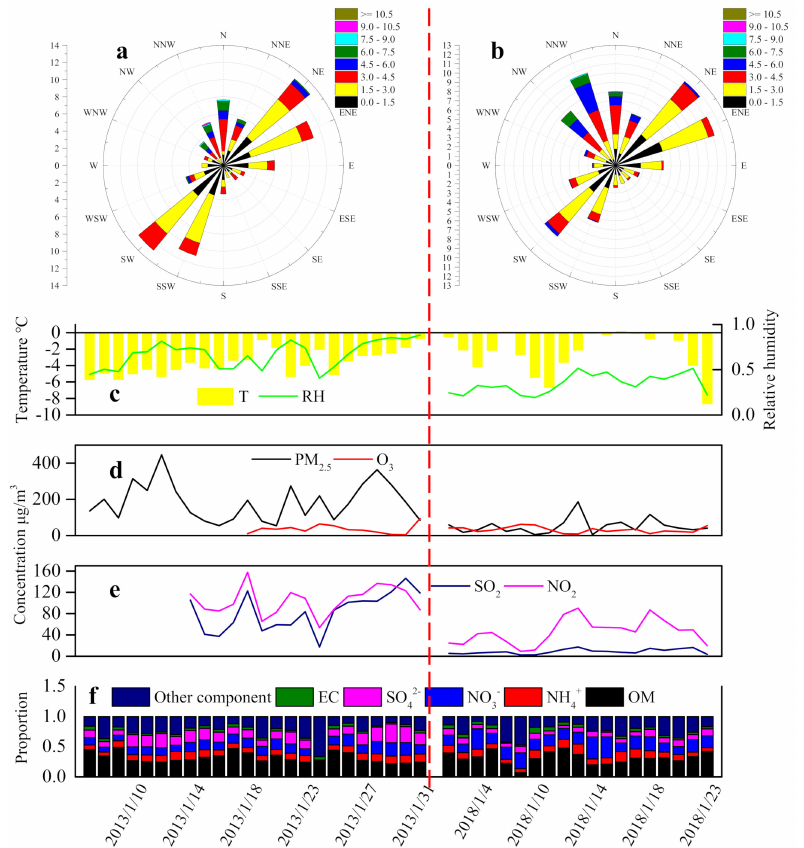
Figure 1. ( a ) Wind rose diagram for January 2013; ( b ) wind rose diagram for January 2018; ( c ) daily temperature (T) and relative humidity (RH); ( d ) daily concentrations of PM 2.5 and O 3 ; ( e ) daily concentrations of NO 2 and SO 2 ; ( f ) daily chemical composition of PM 2.5